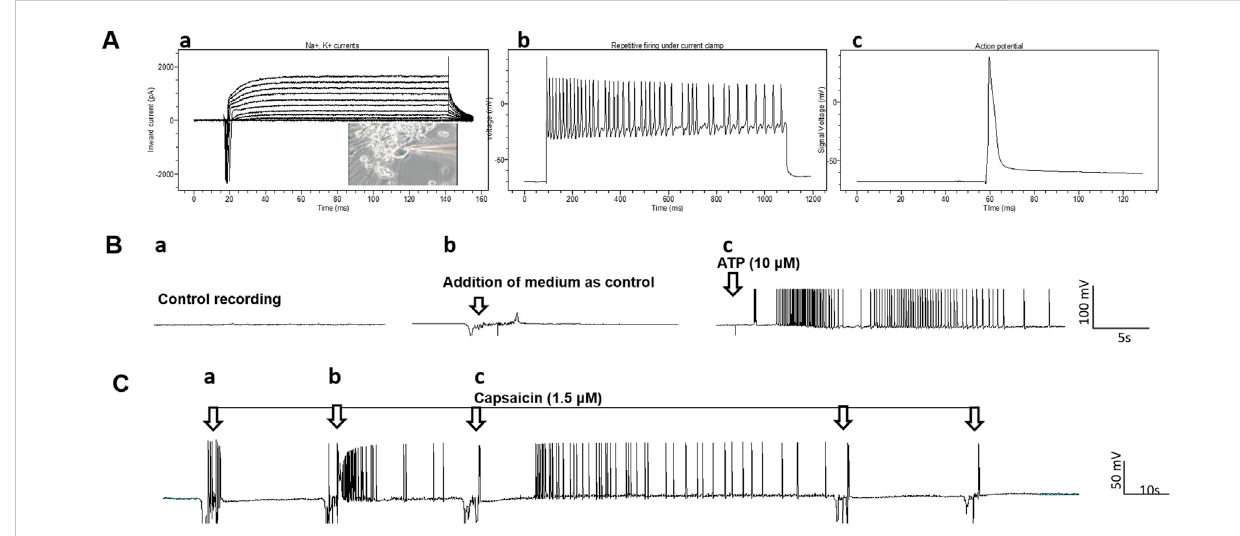
FIGURE 4 Patch clamp analysis of the iPSC-derived nociceptors. (A) , a) Recording of Na + , K + currents under voltage clamp conditions. The inset is the phase imageofthecellpatched, b) recordingsofrepetitive fi ringundercurrentclampconditionsand c) actionpotential. (B) ResponseofiPSC-nociceptors(Day 16) to ATP recorded in patch clamp gap free mode. a) Baseline recording indicated no spontaneous fi ring, b) addition of medium didn ’ t induce neuronal activity except random artifacts and c) addition of ATP (10 µM) induced robust fi ring after a short delay. (C) Response of iPSC-nociceptors to Capsaicin recorded by patch clamp gap free mode. Initial addition of Capsaicin didn ’ t induce neuronal activity except random artifacts, while additional additionofcapsaicin(1.5 µM)inducedrobust fi ringafterashortdelay.However,furtheradministrationinducednoadditionalactivity,whichisreminiscent of the therapeutic effects of Capsaicin for pain induction.